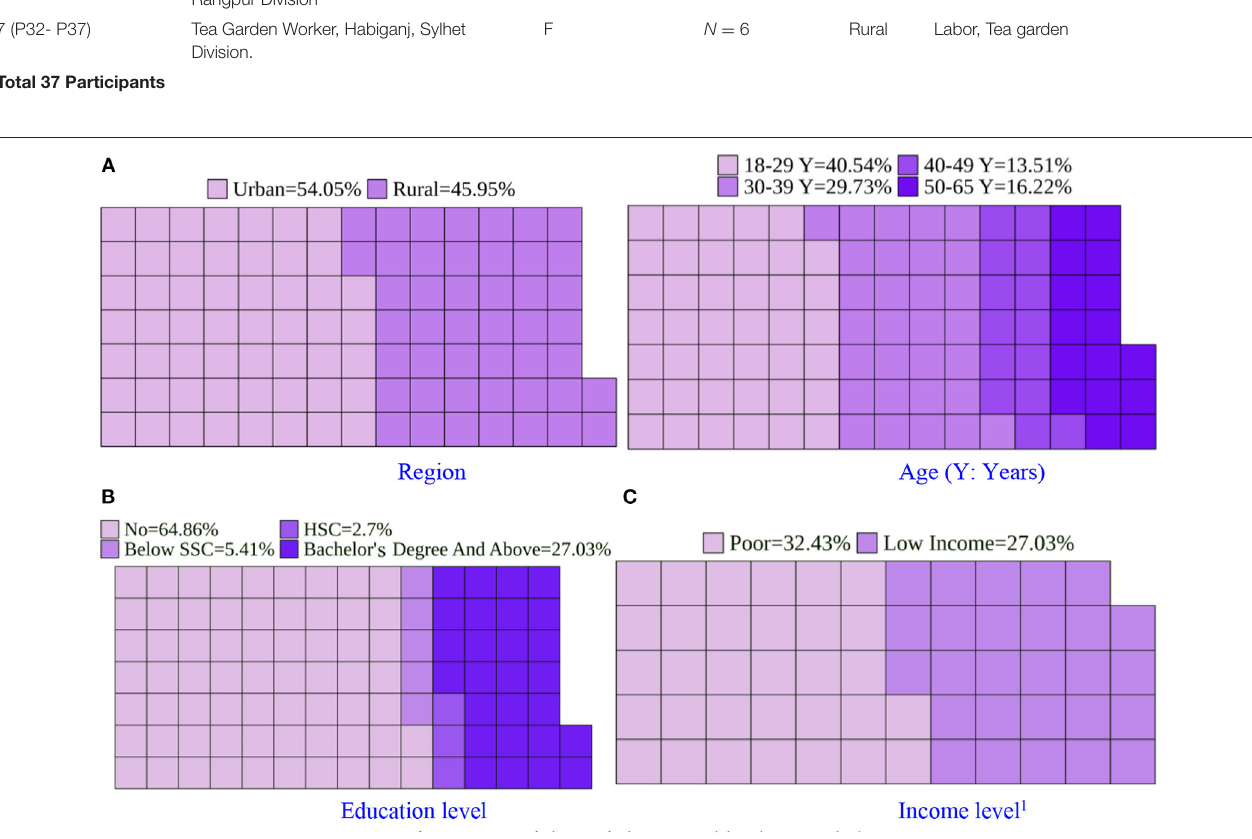
FIGURE 2 | Participants’ demographic characteristics. (A) Region and Age (Y: Years). (B) Education level. (C) Income level. 1 Nine participants (24.32%) were housewives and 6 participants (16.22%) were students for whom income level classification was not applicable due to not having any personal income.